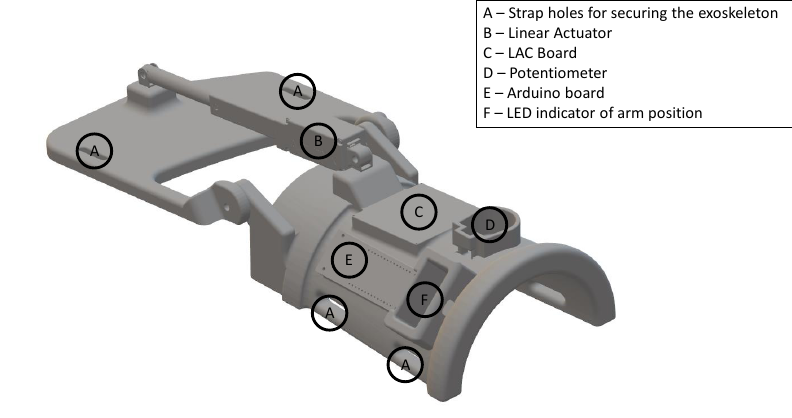
Figure 4. View of the 3D-printed exoskeleton. The illustration is not drawn to scale. The surfaces that were in contact with the forearm and hand were padded with foam to improve the comfort. The exoskeleton was fixated to the subject’s hand and forearm with Velcro straps (A). ‘LAC’: Linear Actuator